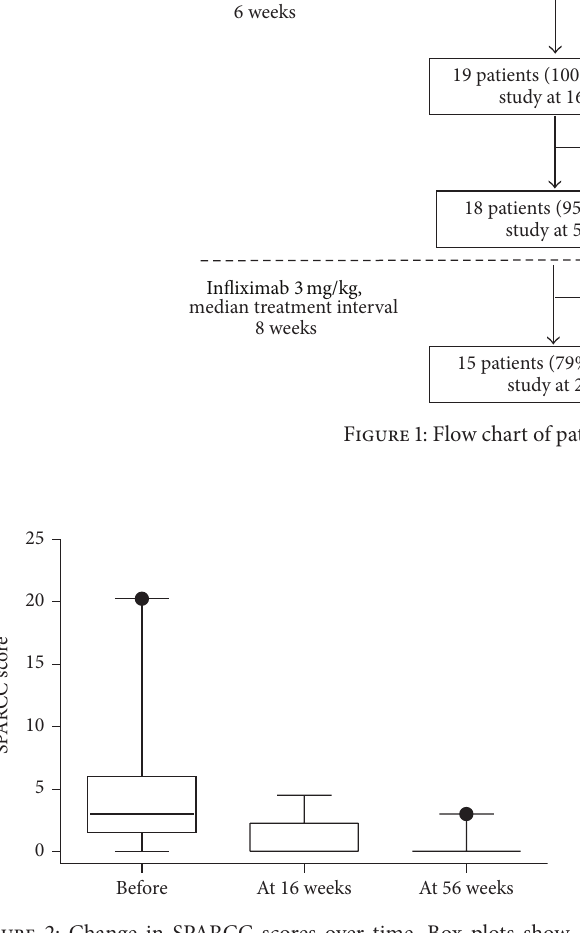
Figure 2: Change in SPARCC scores over time. Box plots show the 25th and 75th percentiles. Horizontal solid lines within boxes indicate medians and vertical bars indicate the 5th and 95th